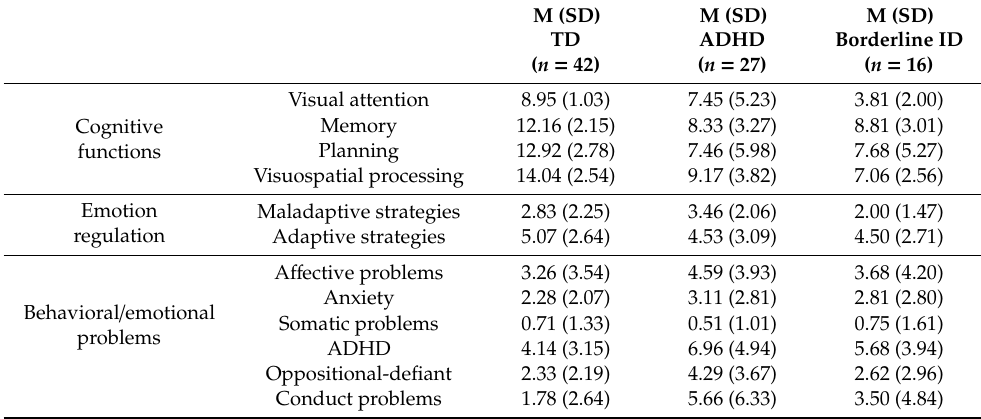
Table 1. Means (M) and standard deviations (SD) for cognitive functions, emotion regulation strategies, and behavioral / emotional problems